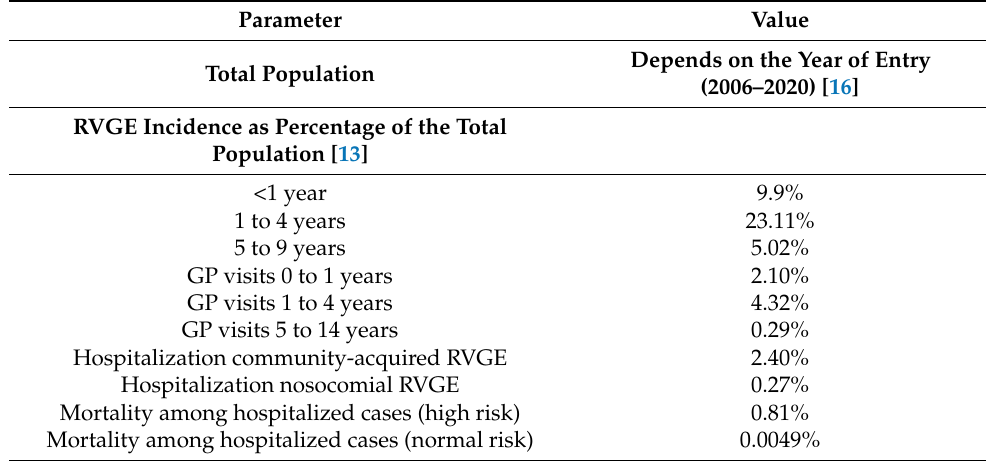
Table 1. Total population and probabilities of incidence, general practitioner visits, hospitalizations, and mortality of rotavirus infection in the population.